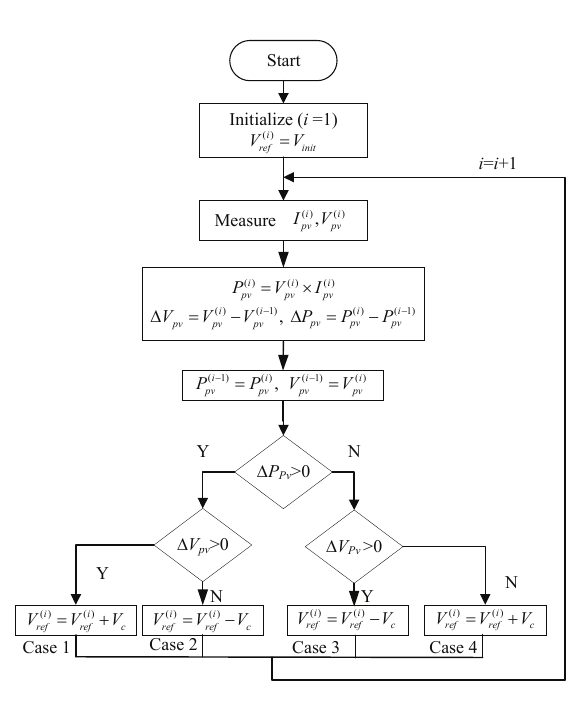
Figure 4. Flowchart of INC